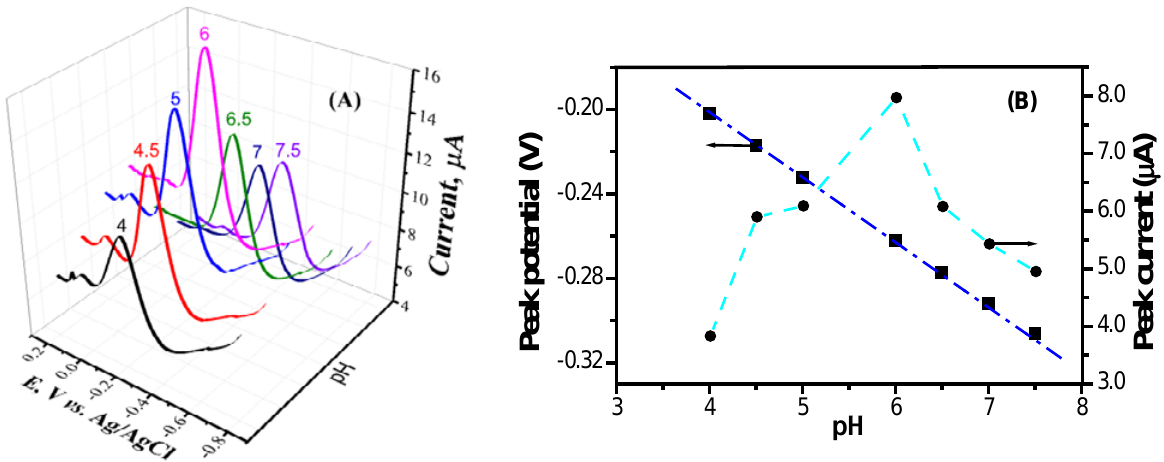
Scheme 1. Toluidine blue electro-oxidation mechanism.